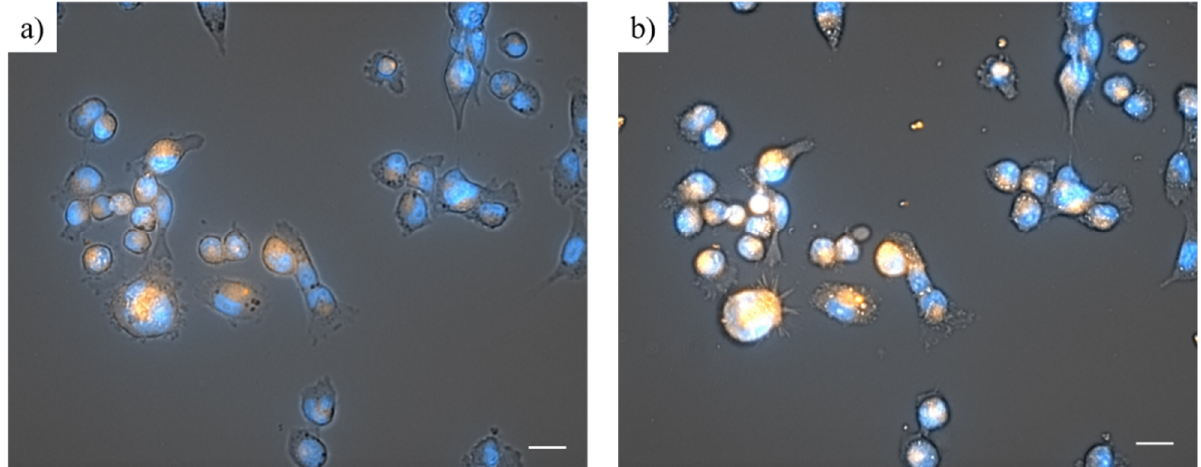
Figure 4. MDA-MB-231 cells 5 min ( a ) and 30 min ( b ) after the beginning of the treatment with FA 2 -dPEG-DOX 2 at 16 µM concentration (regarding FA). The blue color shows the cell nuclei, while the orange color is the doxorubicin. The scale bars indicate 25 µM. The images were taken by the Zeiss Celldiscoverer 7 automated platform.